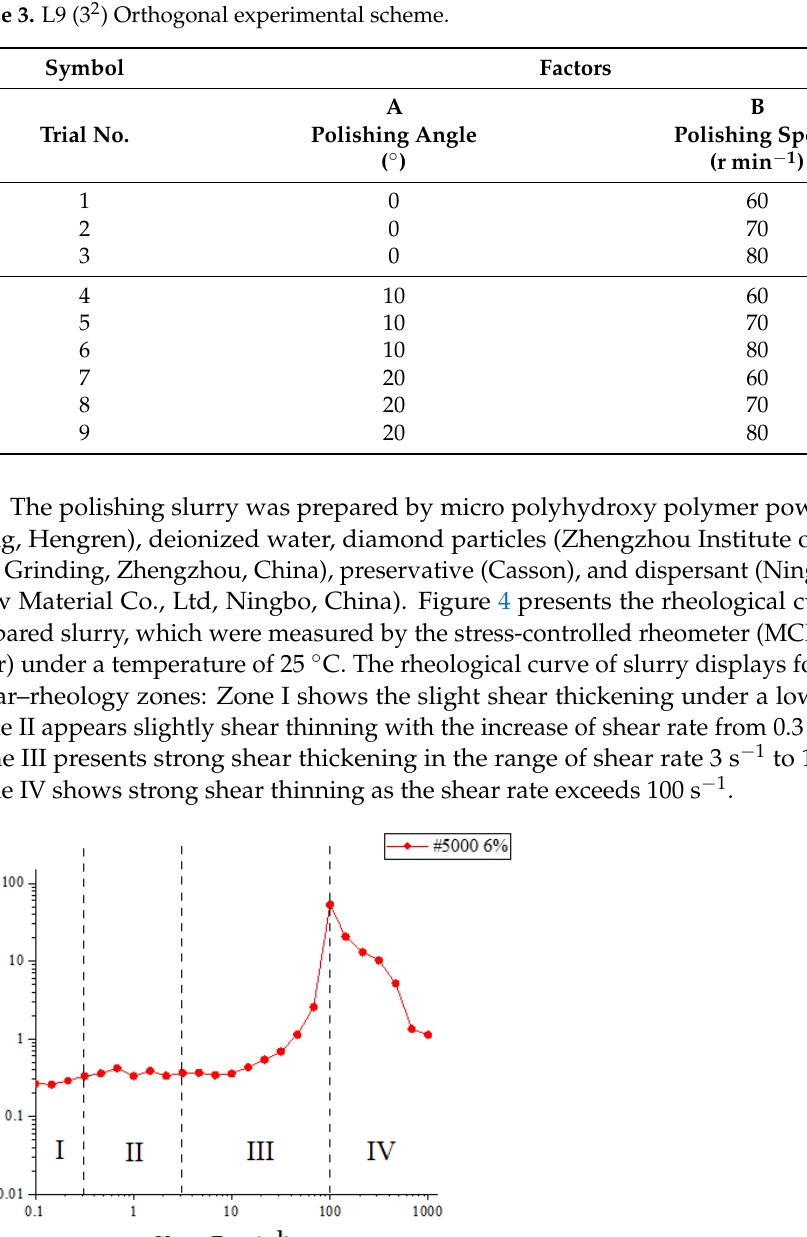
6 of 16 Table 3. L9 (3 2 ) Orthogonal experimental scheme. Symbol